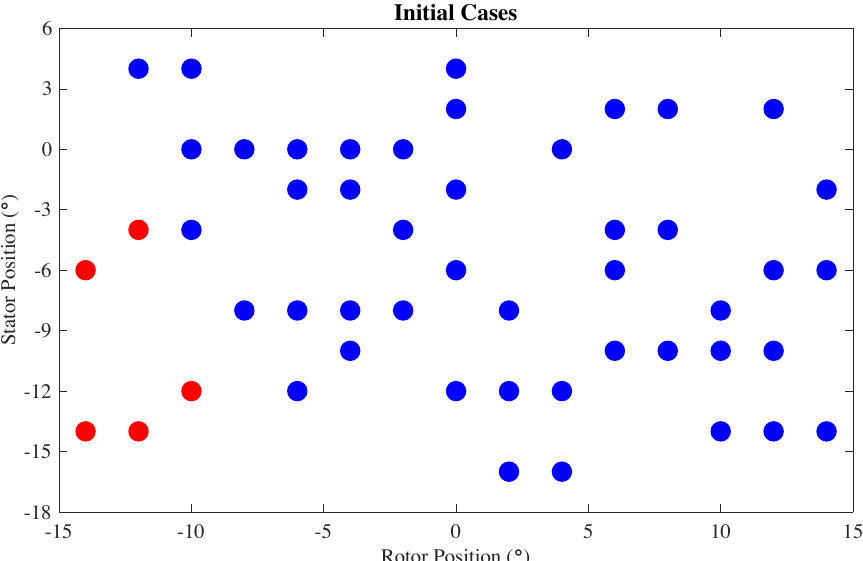
Figure 4. Scatter plot of the 50 cases selected by the LHS approach that make up the initial data set. Unfeasible designs are colored in red.